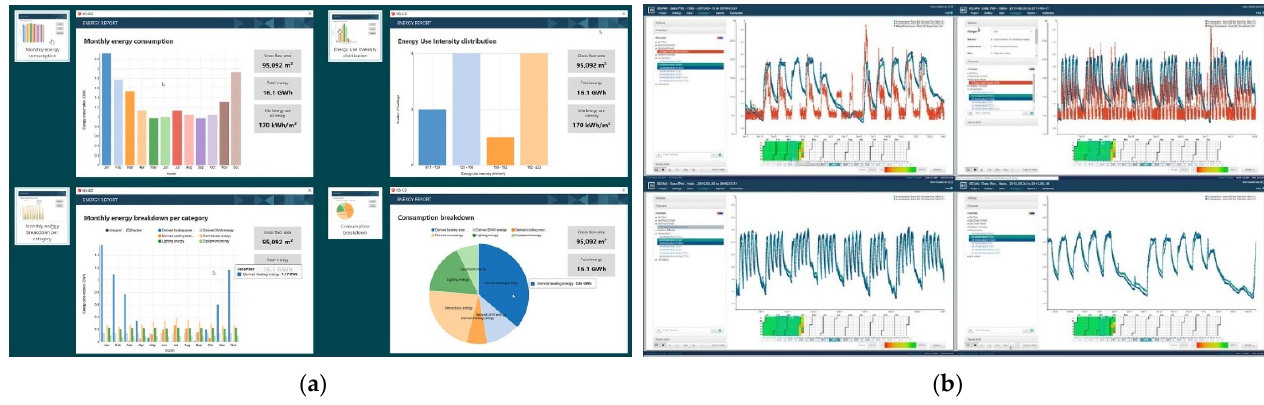
Figure 8. Phase 6 of realized case studies: ( a ) representation of energy consumption; ( b ) control over costs (money flow) [41].